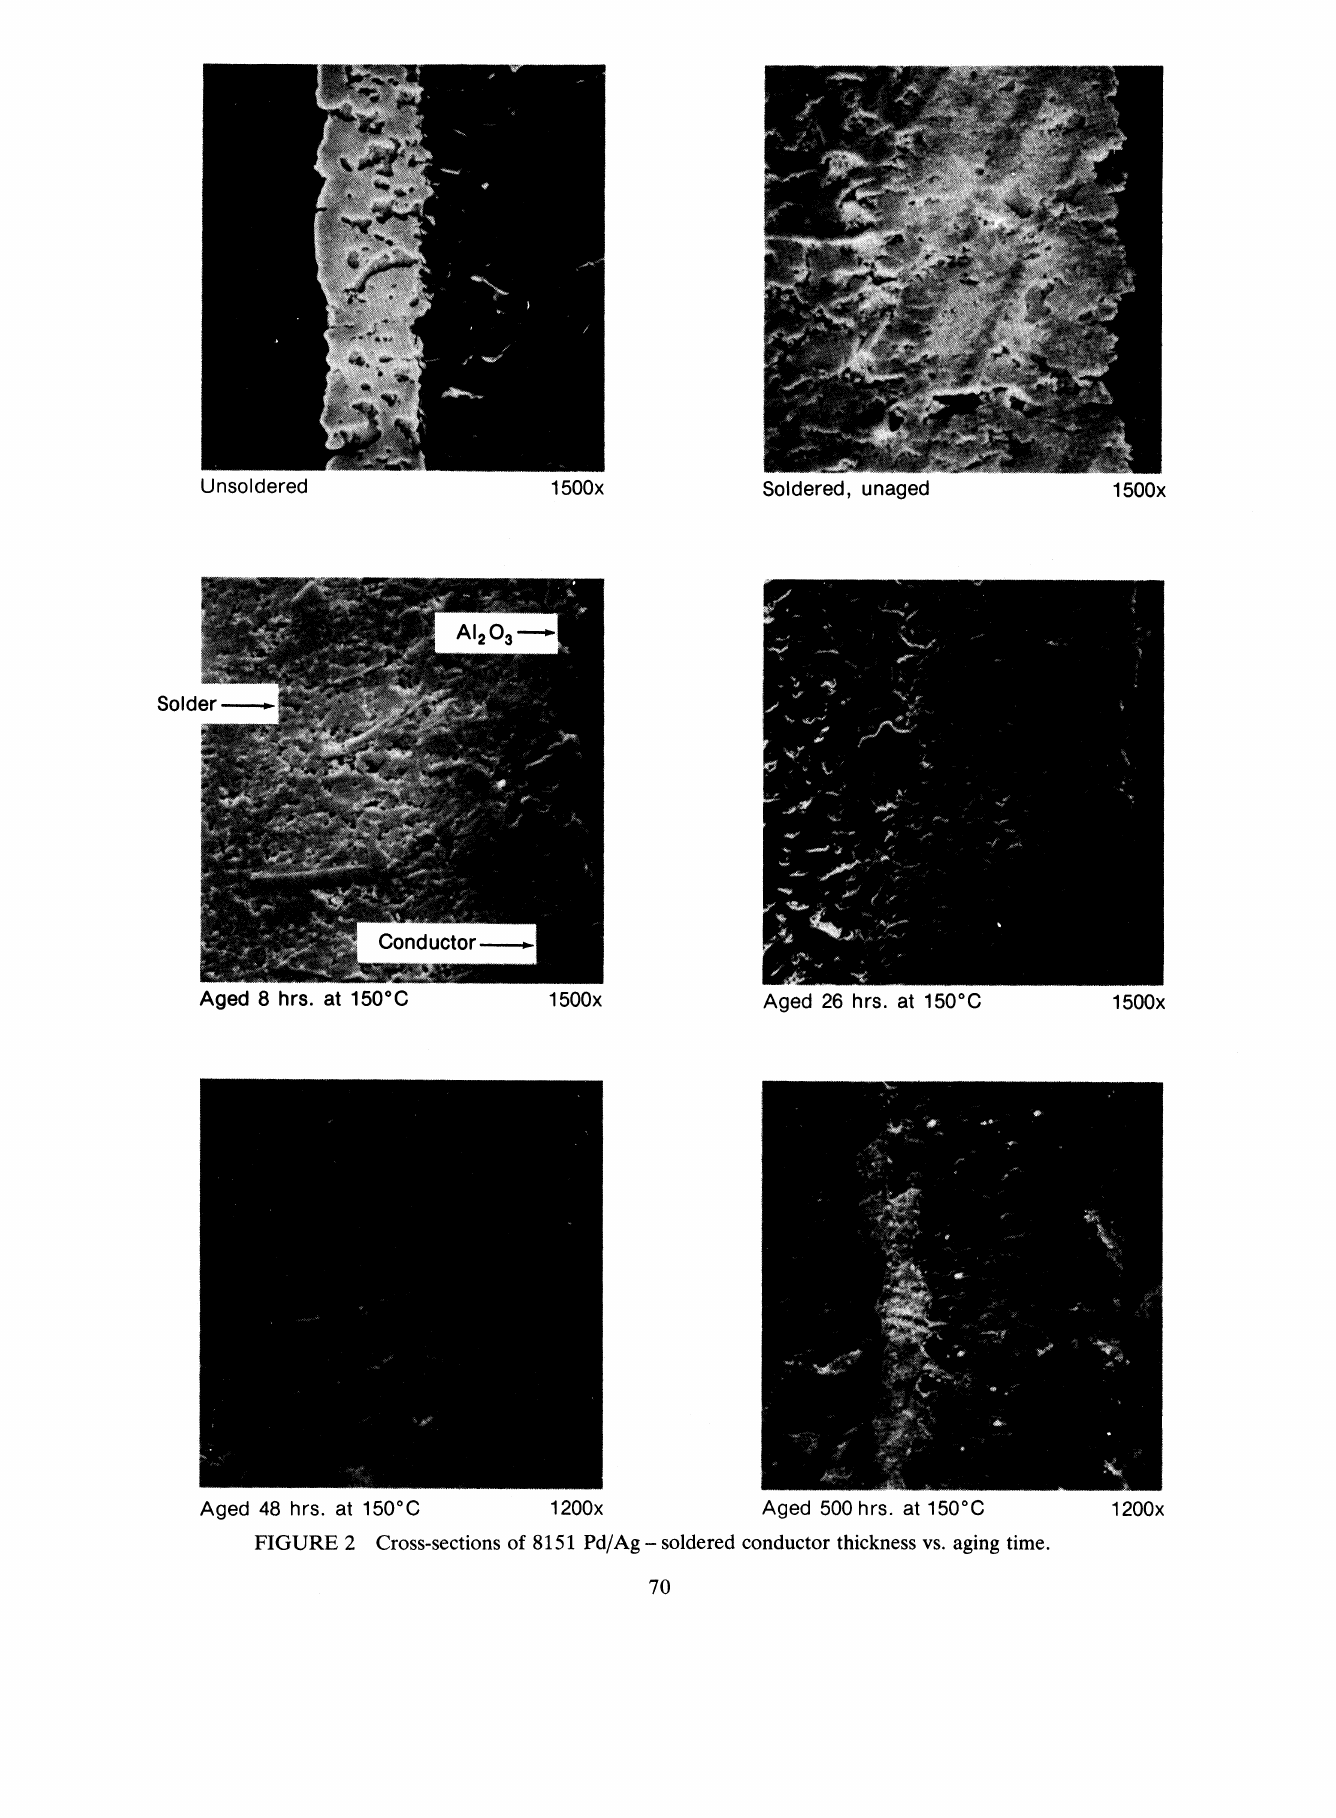
FIGURE 2 Cross-sections of 8151 Pd/Ag- soldered conductor thickness vs. aging